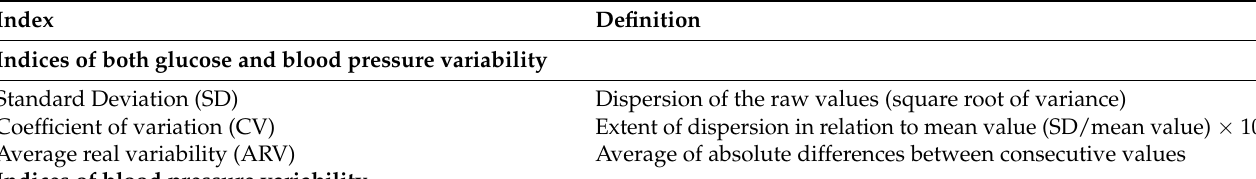
Table 1. Commonly used indices of glycemic and blood pressure short- and mid-term variability